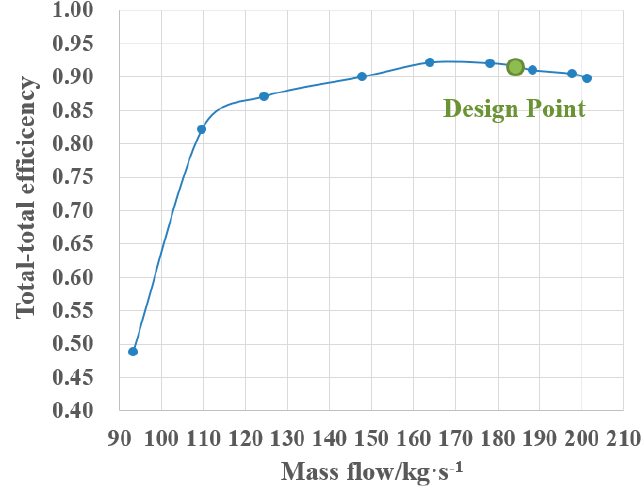
Figure 12. The variation curve of total-total efficiency with mass flow rate.